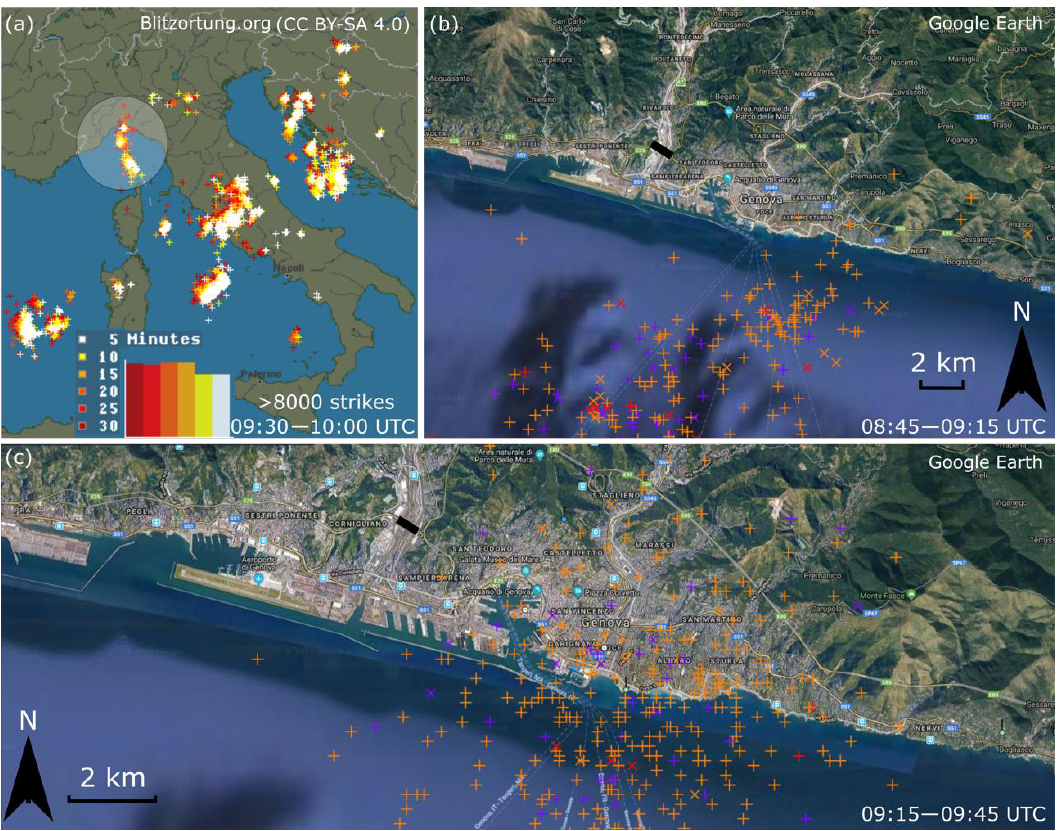
Figure 7. ( a ) Lightning strikes recorded between 09:30 and 10:00 UTC on 14 August 2018 over Italy and the surrounding regions (source: Blitzortung.org). ( b) ,( c ) Lightning Network of the Italian Air Force Meteorological Service (LAMPINET) counts of lightning strikes above Genoa in two different time intervals (background maps source in ( b ),( c ): “© Google Earth”). The thick black line in ( b ),( c ) shows the location of Morandi Bridge.